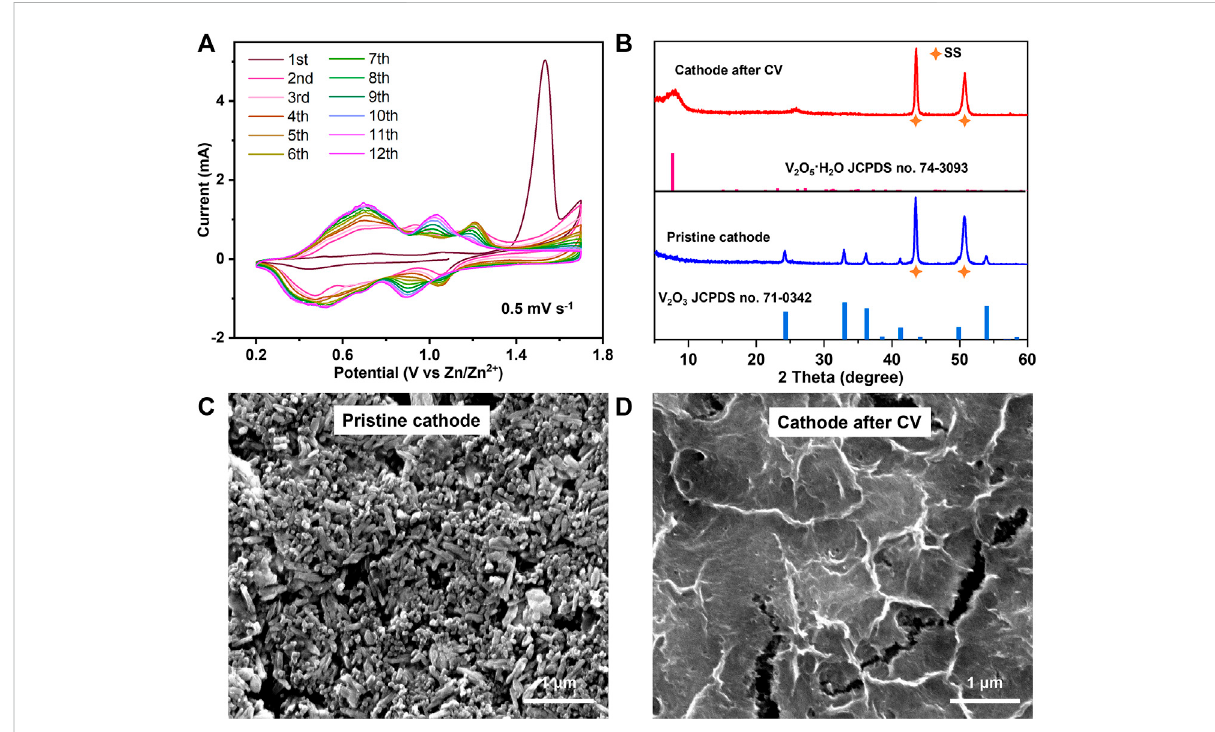
FIGURE 2 (A) CV curves of the V (B) XRD patterns and (C,D) SEM images of a pristine cathode and cathode after CV in 2 O 3 @C cathode in 2 M ZnSO 4 . Figure 2A for the